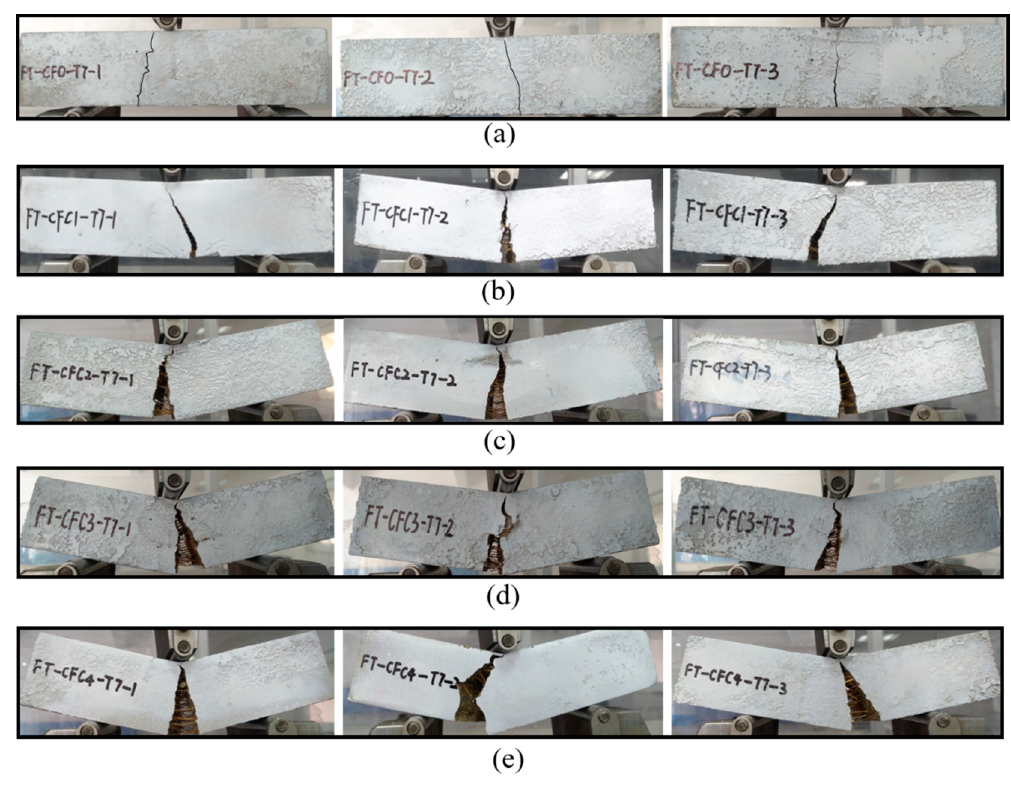
Figure 5. Failure modes of group T7: ( a ) CF0-T7; ( b ) CFC1-T7; ( c ) CFC2-T7; ( d ) CFC3-T7; ( e ) CFC4-T7.